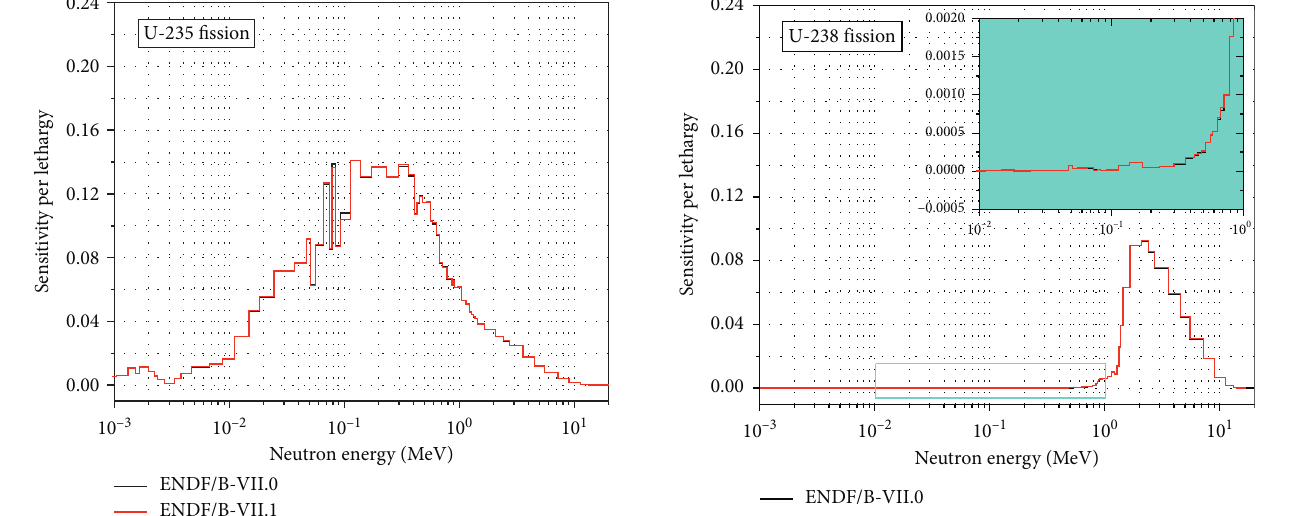
Figure 8: Energy-dependent sensitivities of k cross